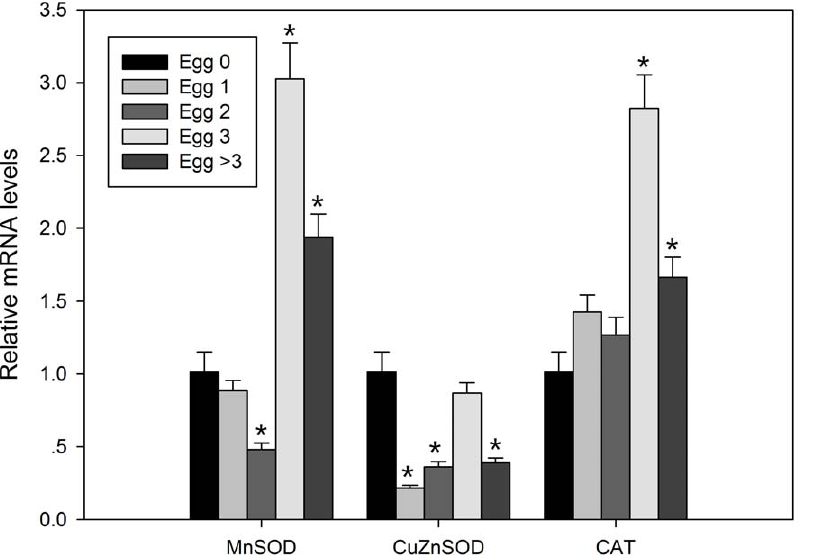
Figure 5. Relative mRNA expression levels of MnSOD, CuZnSOD and CAT from female B.calyciflorus carrying different numbers of eggs. Bars represent standard errors. Egg 0, Egg 1, Egg 2, Egg 3 and Egg . 3 represent rotifers carry 0, 1, 2, 3 and 4 or more eggs, respectively. The expression levels were statistically analyzed by one-way ANOVA with the Tukey test. ( * P , 0.05).